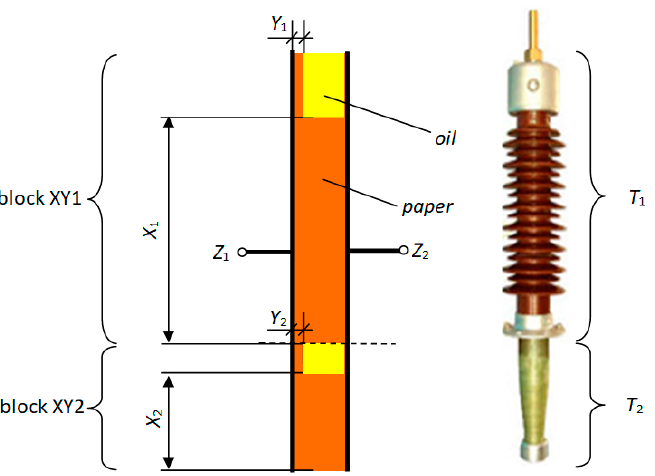
Figure 10. The 2XY model representing a bushing whose overhead part (block XY1) is at temperature T 1 , and oil part (block XY2) is at temperature T 2 .